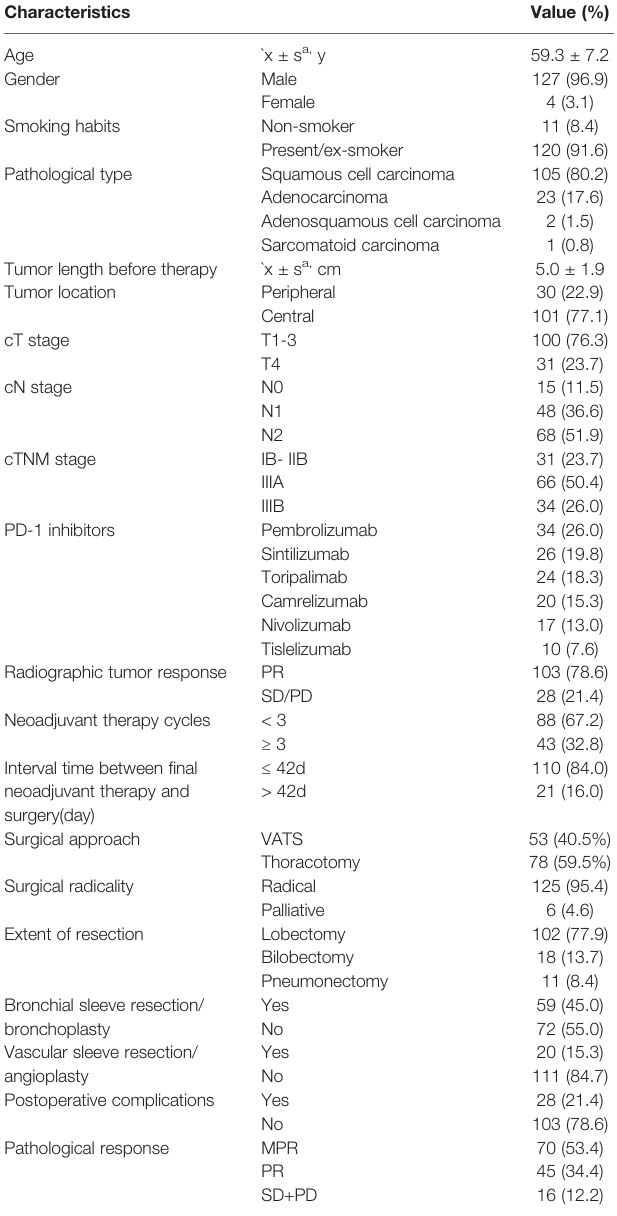
TABLE 1 | Baseline characteristics for 131 NSCLC patients received neoadjuvant PD-1 inhibitors plus chemotherapy. Characteristics